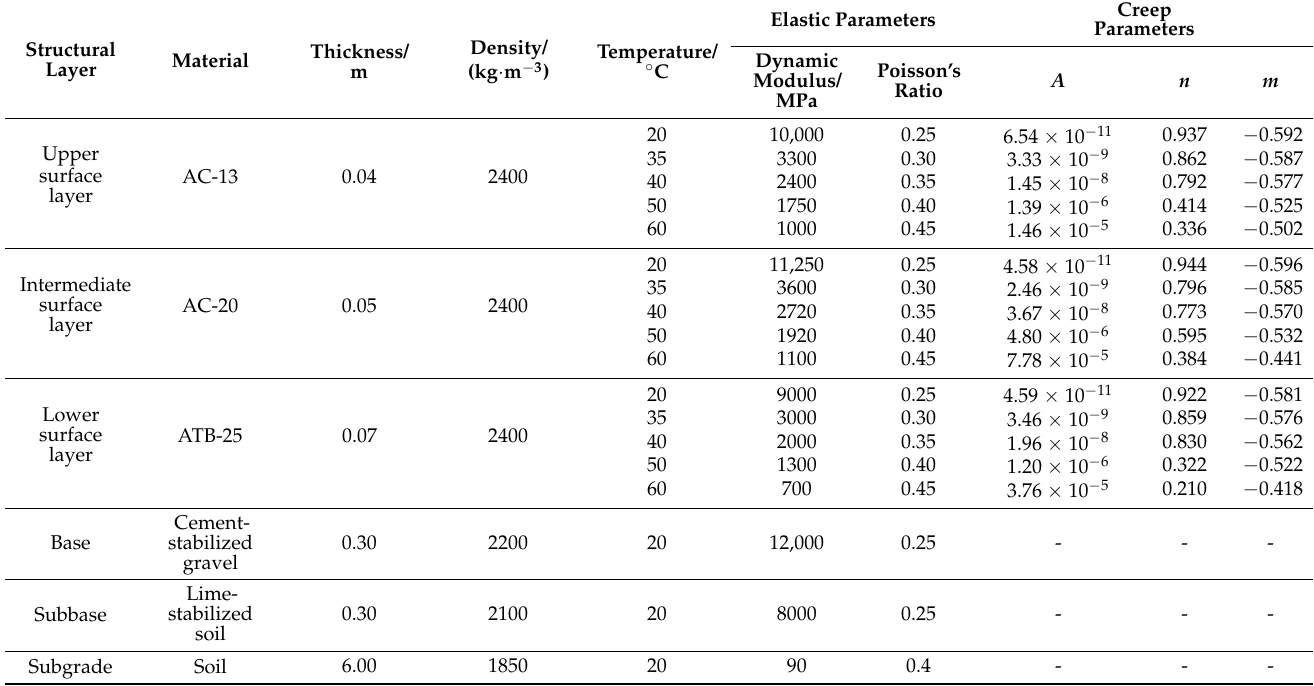
Table 1. Structural and material parameters of BRT asphalt pavement.